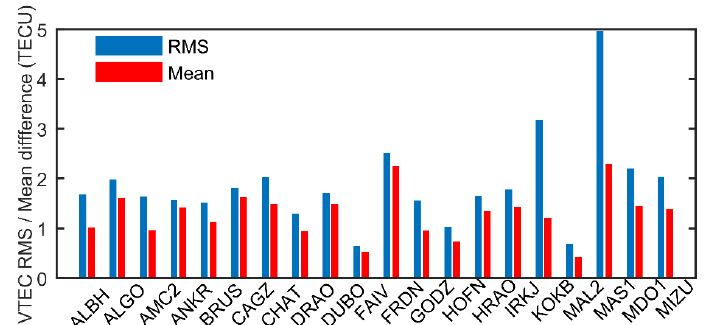
Figure 3. Local horizontal gradient derived from recursive method over GODZ station on 15 th January 2011.